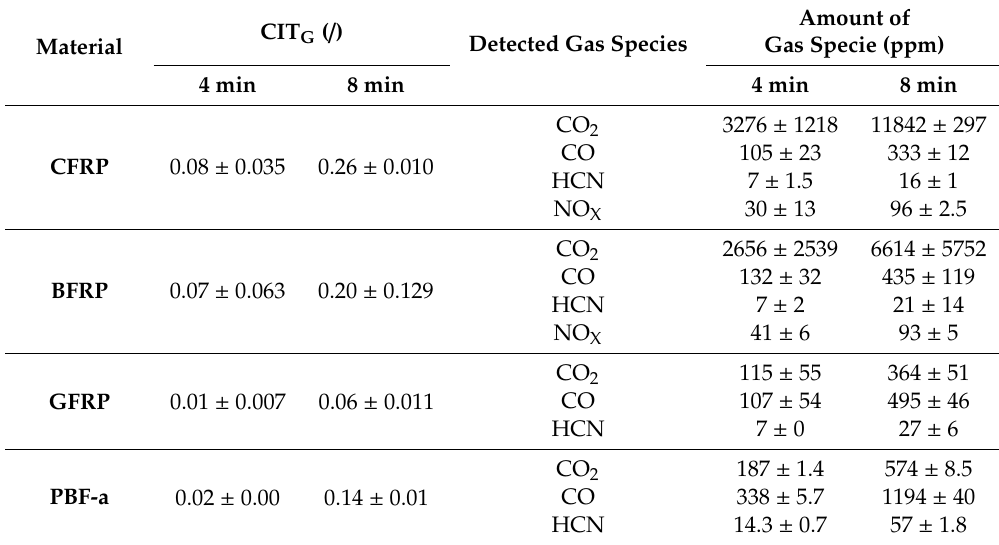
Figure A2. Neat PBF-a as well as carbon, glass and basalt fiber reinforced PBF-a before and after smoke chamber testing. Table A8. Detected smoke gases in smoke chamber testing of neat PBF-a as well as carbon, glass and basalt fiber reinforced PBF-a.